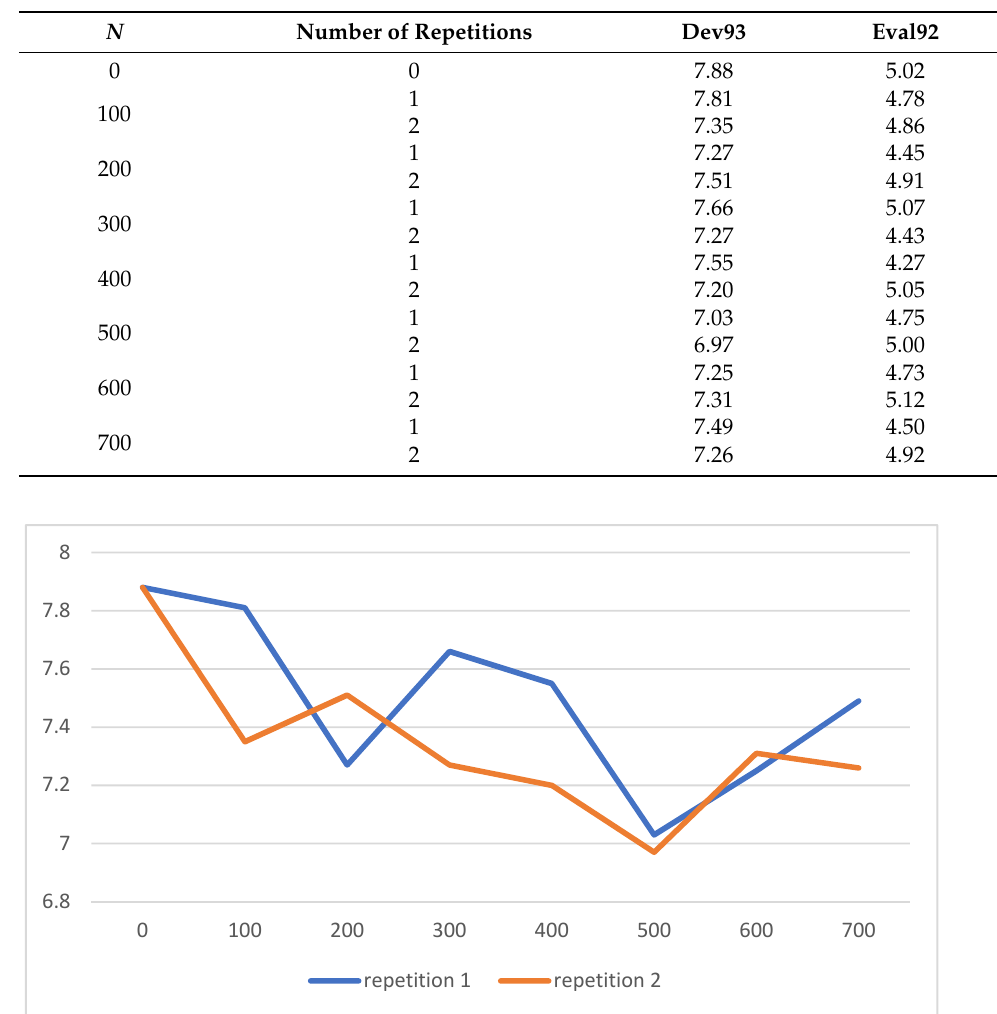
Figure 6. WER results of WSJ database according to augmented frame range. The horizontal axis denotes the maximum augmentation range and the vertical axis denotes WER. Table 2. WER (%) results of LibriSpeech database according to the maximum augmentation range N when s ∼ Uniform [ 0.9,1.1 ]